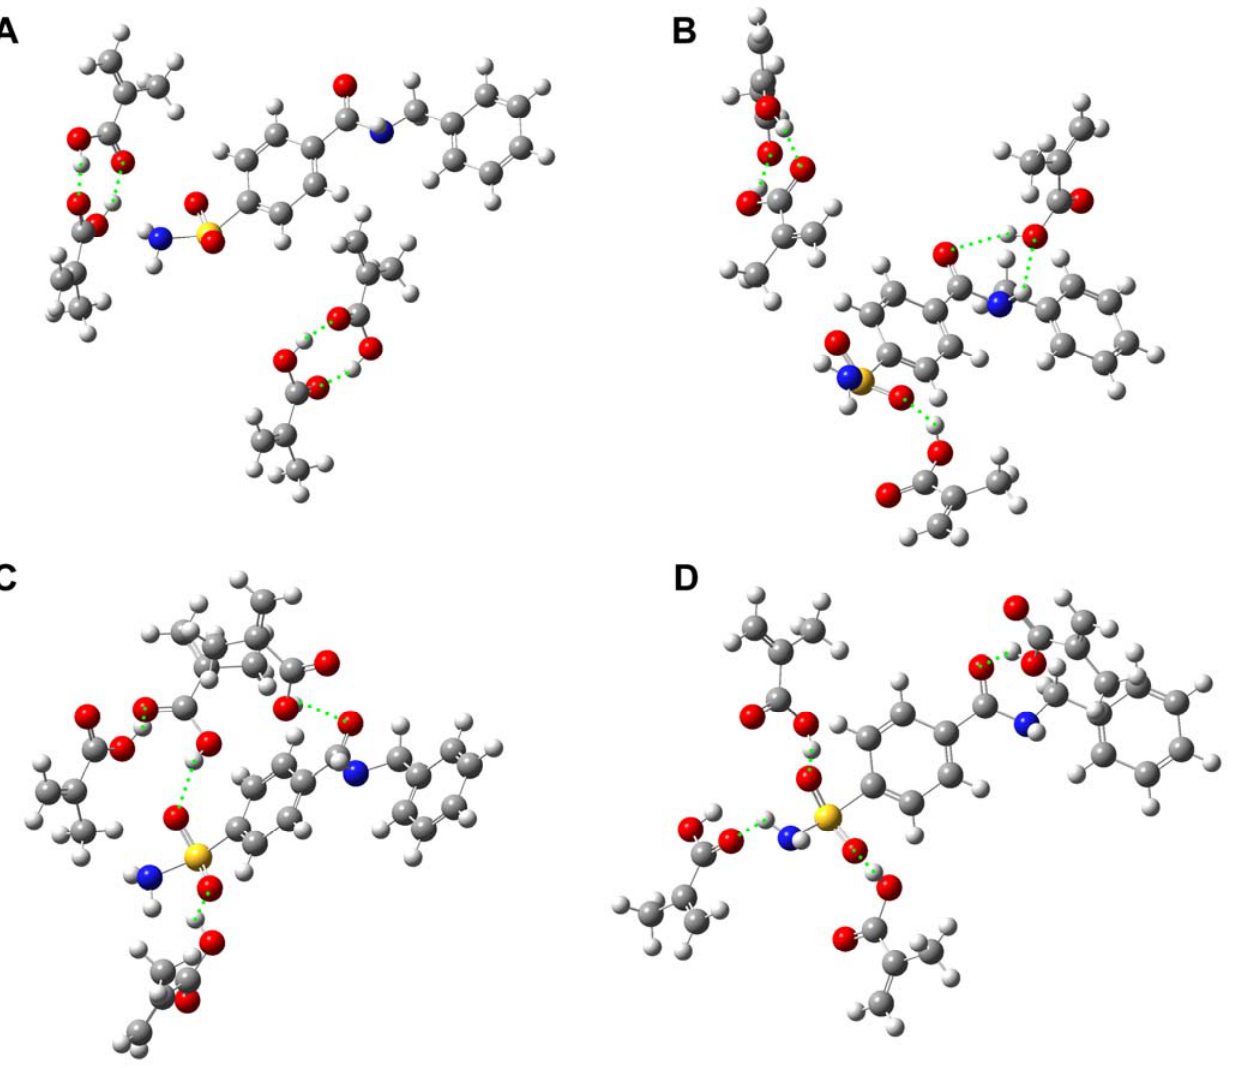
Figure 3. Sampling of some of the possible modes of interaction of template 1 with MAA. Two MAA dimers with no interaction with template (A), one MAA dimer formation and two MAAs interacting with template (B), incomplete MAA dimer formation interacting with template with two MAA interacting with template (C), and four MAA interacting with template. Other possible conformations that may exist are not shown. Hydrogen bond interactions are represented by green dotted